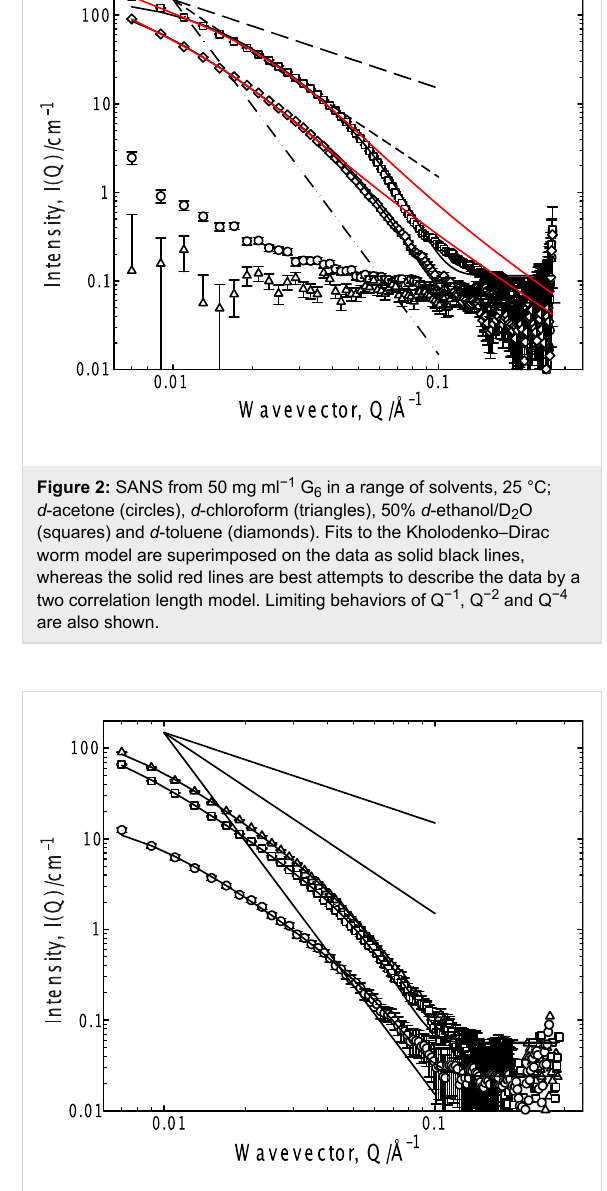
Figure 3: SANS from G 6 25 °C in d -toluene as a function of G 6 concentration; 5 mg ml − 1 (circles), 10 mg ml − 1 (squares) and 50 mg ml − 1 (triangles). Fits to the Kholodenko–Dirac worm model are super- imposed on the data. Limiting behaviors of Q − 1 , Q − 2 and Q − 4 are also